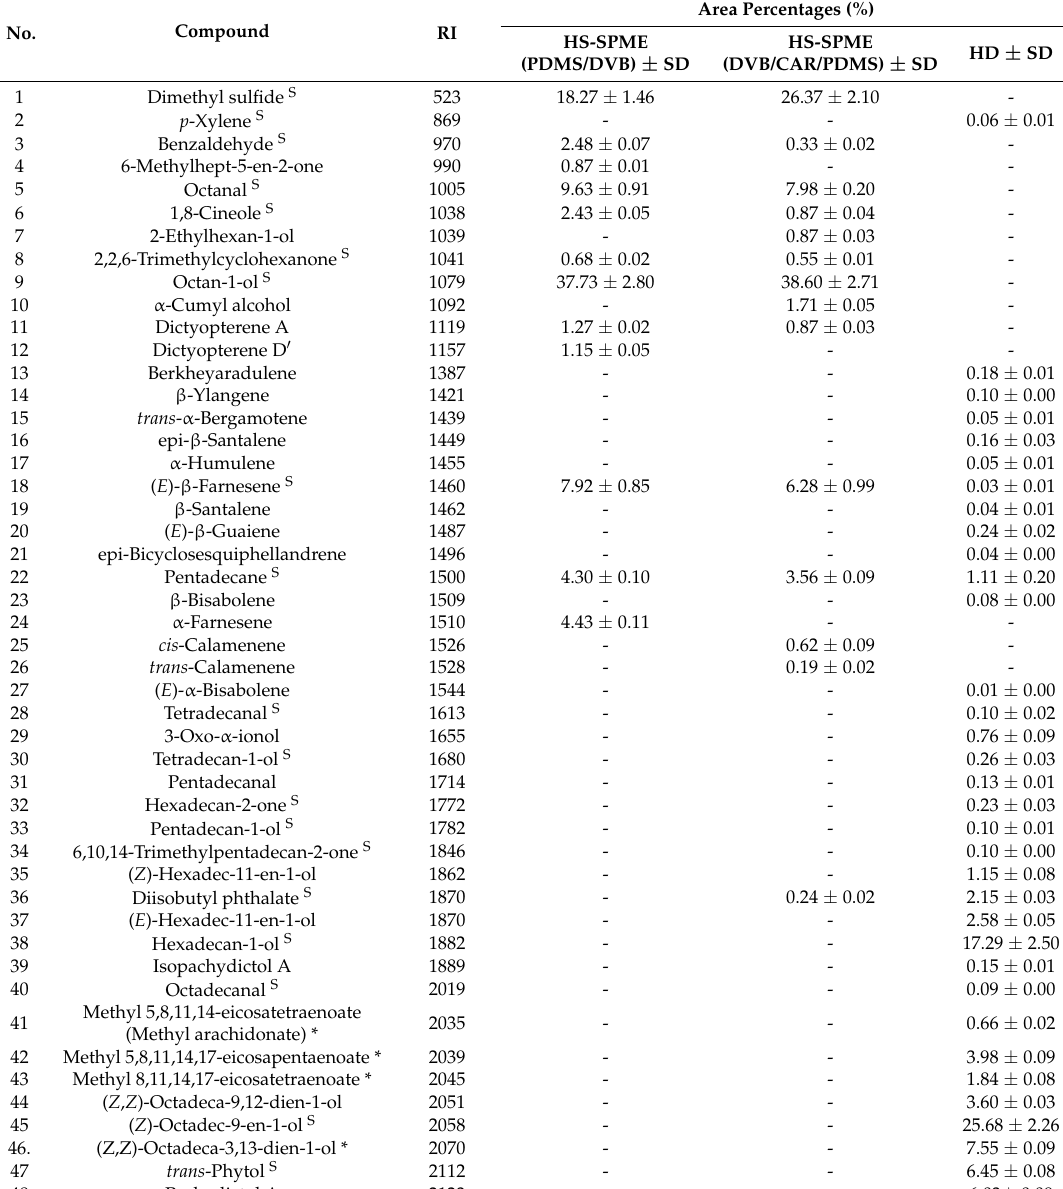
Table 2. Headspace and volatile oil composition of P. pavonica